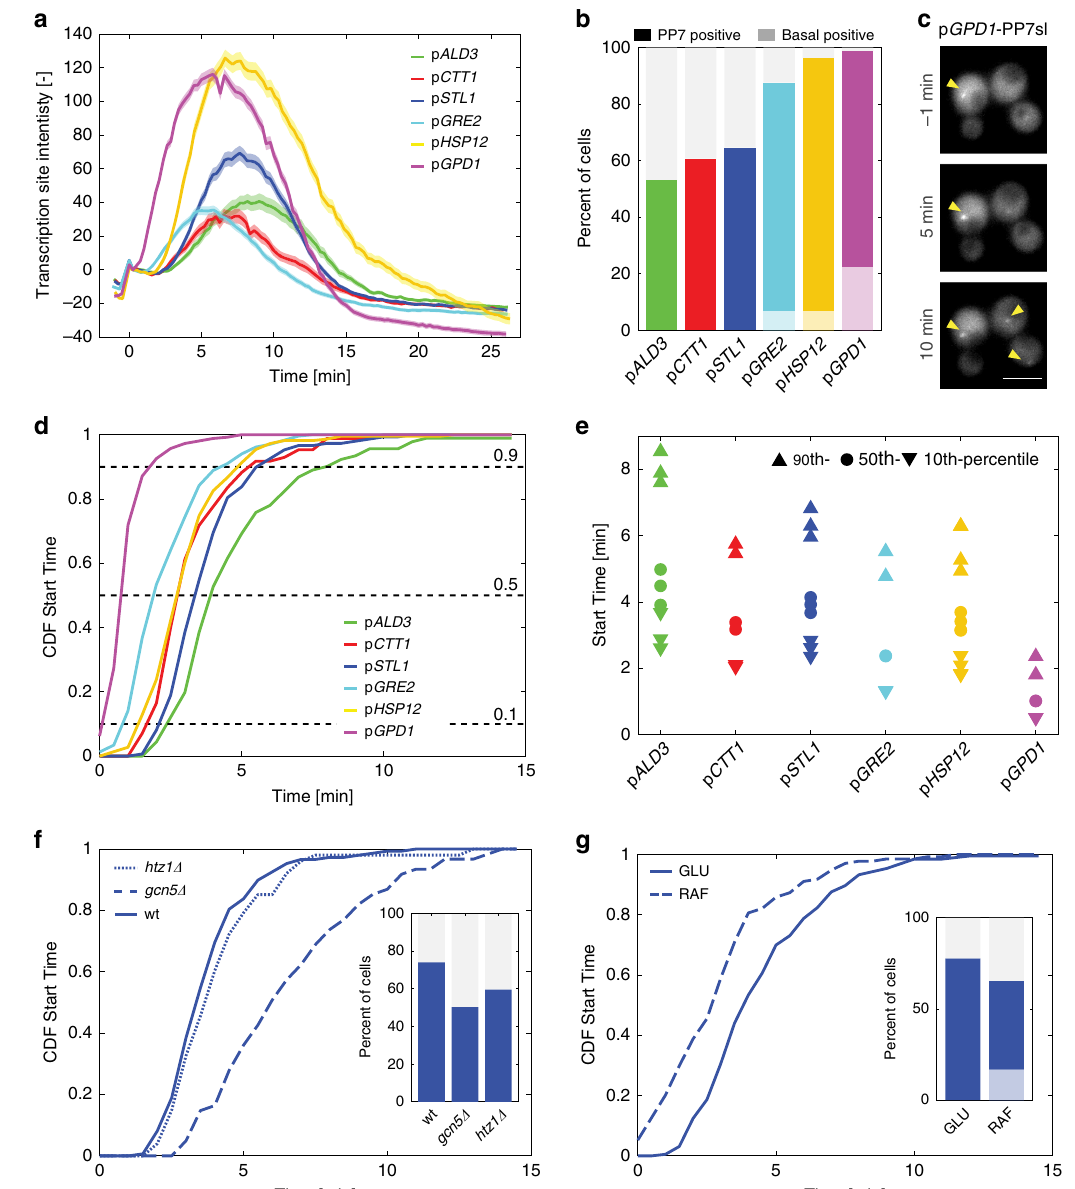
Fig. 2 Chromatin state dictates the transcription initiation of stress-induced promoters. a Dynamics of the transcription site intensity from six different promoters following a 0.2 M NaCl stress. The mean of at least 140 cells is represented by the solid line. The shaded areas represent the s.e.m. Number of cells for each trace: p ALD3 : 171; p CTT1 : 140; p STL1 : 229; p GRE2 : 289; p HSP12 : 243; p GPD1 : 335. b Percentage of cells where a PP7 TS site was detected. The light shaded area represents the percentage of PP7 positive cells before the stimulus was added (basal transcription). c The microscopy thumbnails display cells bearing the p GPD1 -PP7sl reporter system, where transcription sites (arrow heads) can be detected before and after the stress of 0.2 M NaCl. Scale bar represents 5 µ m. Representative images from at least three biological replicates. d Cumulative distribution function (CDF) of the Start Time for each promoter considering only the cells that induce transcription after time zero. e 10th, 50th and 90th percentiles of the Start Times shown for the two to three replicates measured for each promoter. f Cumulative distribution functions of Start Times for the p STL1 -PP7sl strain in wild type, htz1 Δ or gcn5 Δ backgrounds. The inset shows the percentage of PP7 positive cells in each background. g Cumulative distribution functions of Start Times for the p STL1 - PP7sl strain grown in glucose or raf fi nose. The inset shows the percentage of PP7 positive cells, the light blue bar the basal positive PP7 cells. Source data are provided for a , f , and g